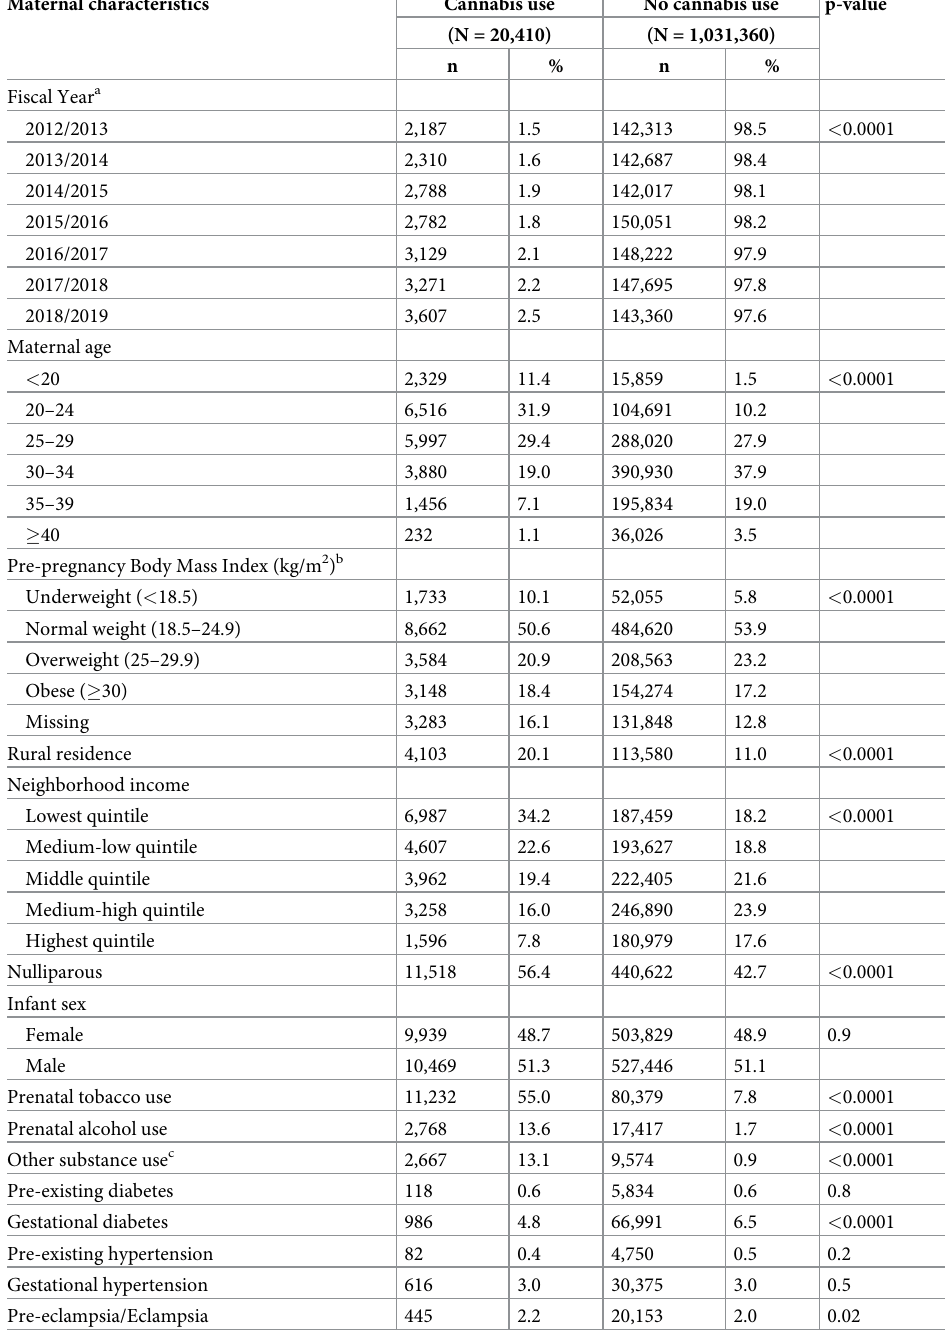
Table 1. Maternal characteristics by prenatal cannabis use, British Columbia, Ontario and Newfoundland and Labrador 2012–2019. Maternal